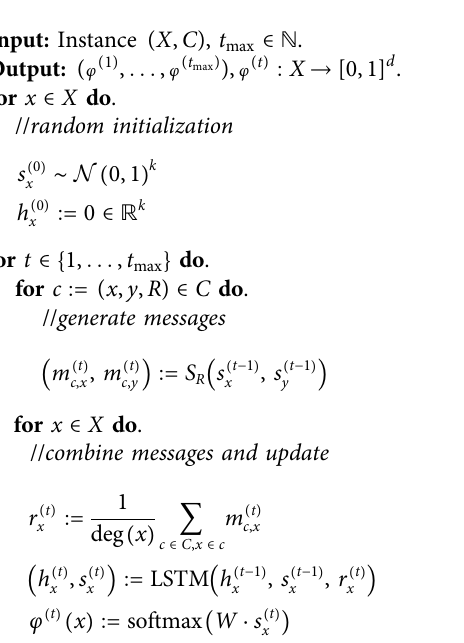
Algorithm 1: Network Architecture. Algorithm 1 speci fi es the architecture in pseudocode.